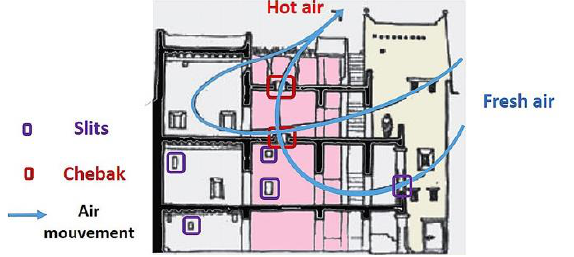
Figure 13. Air circuits through the houses in the M'zab Valley (Bencherif, Chaouche, 2013 treated by the authors) Vegetation: This device is only used in the palm grove of M’zab. night) and their transpiration capacity accelerate the cooling process of the air and surfaces at night and thus the loss of heat, which causes a strong thermal amplitude (Kitous et al.,